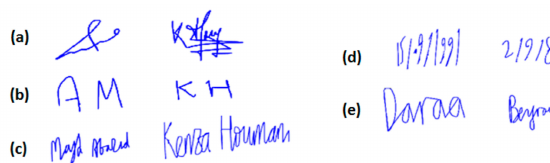
Figure 9. Examples of the simple signature types: ( a ) usual signature; ( b ) initials; ( c ) name-surname,